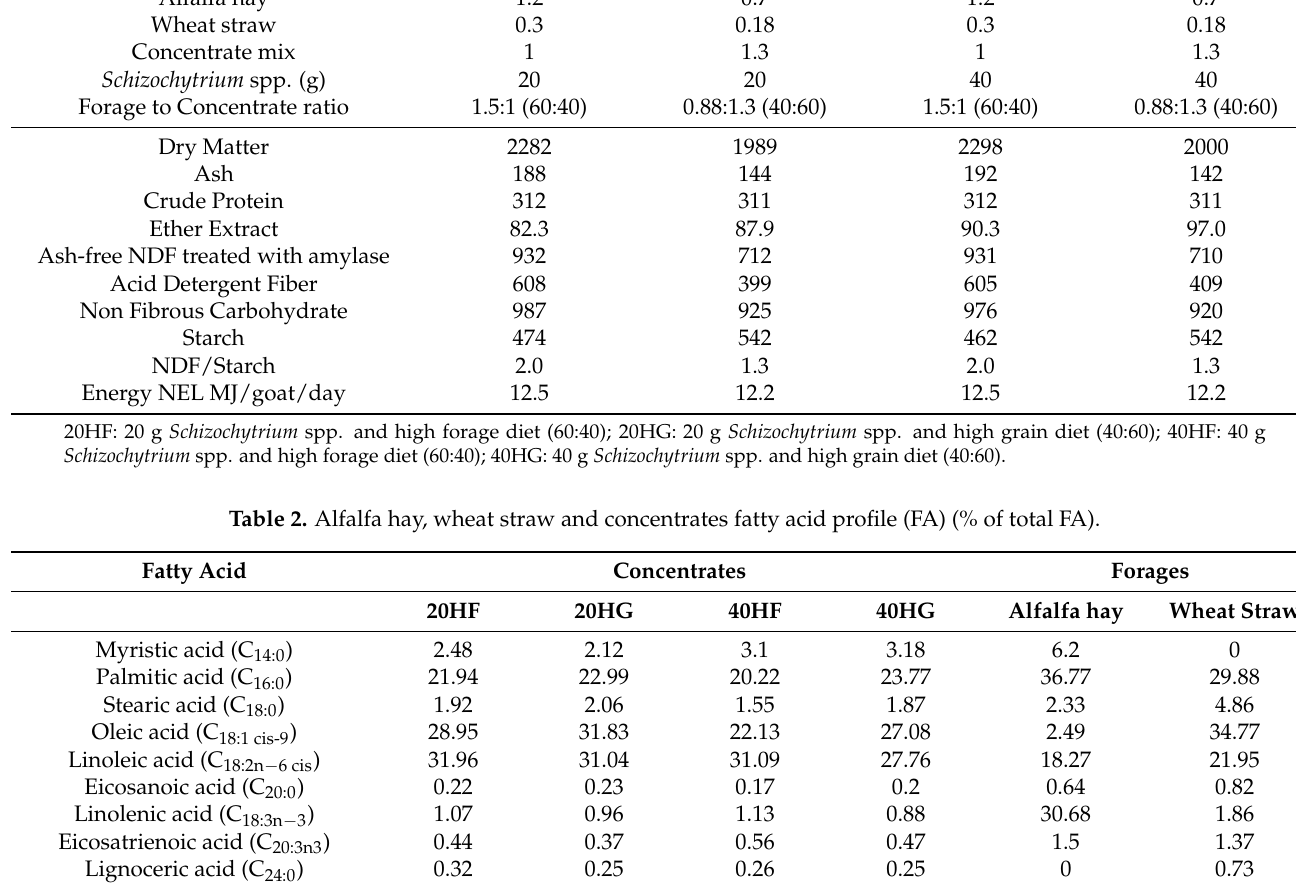
Table 1. Ration components (Kg/goat/day) and chemical composition (g/day) of the diets were administered to the four groups (20HF, 20HG, 40HF, and 40HG) of goats involved in the trials. Treatment 20HF 20HG 40HF